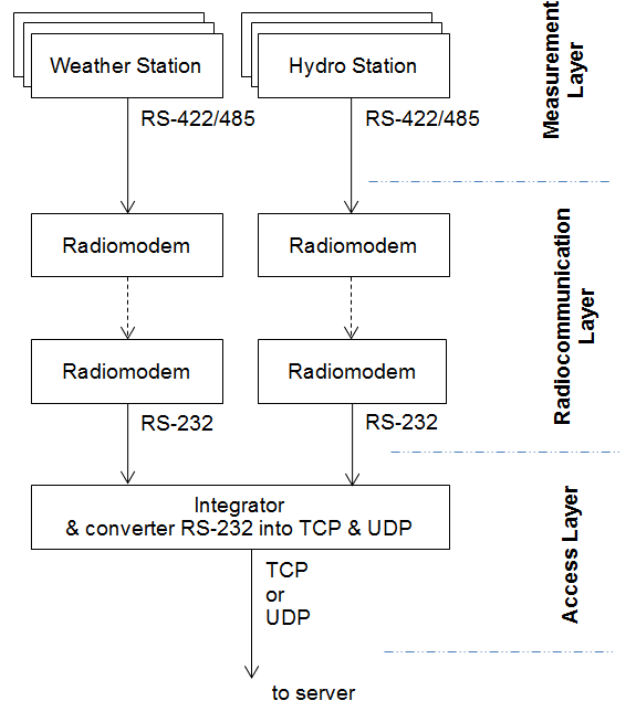
Figure 3. Block diagram of the measurement system.